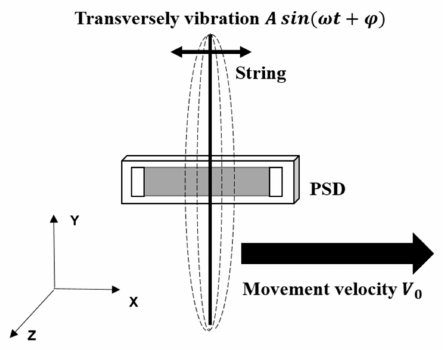
Figure 2. A schematic showing a vibrating string moving across a